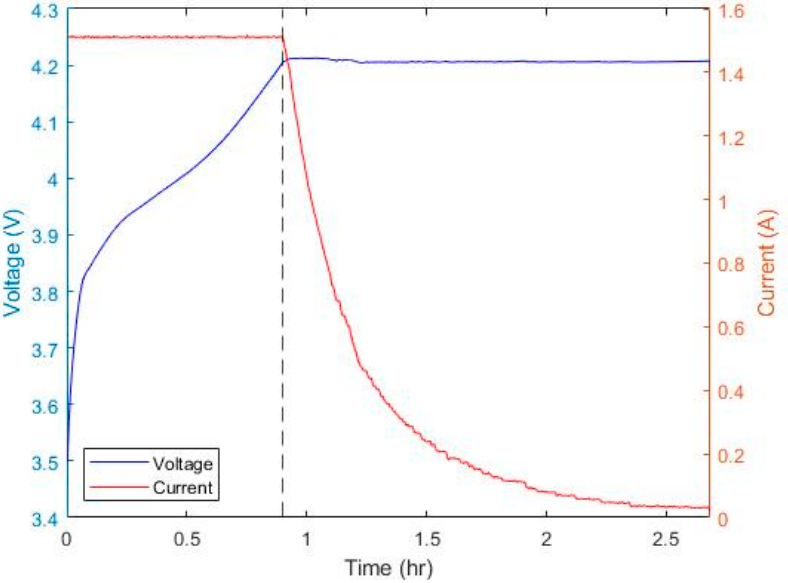
Figure 1. CC and CV charging process.